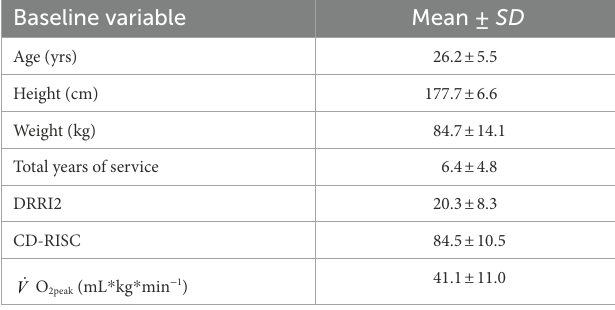
TABLE 1 Total cohort participant characteristics ( N =